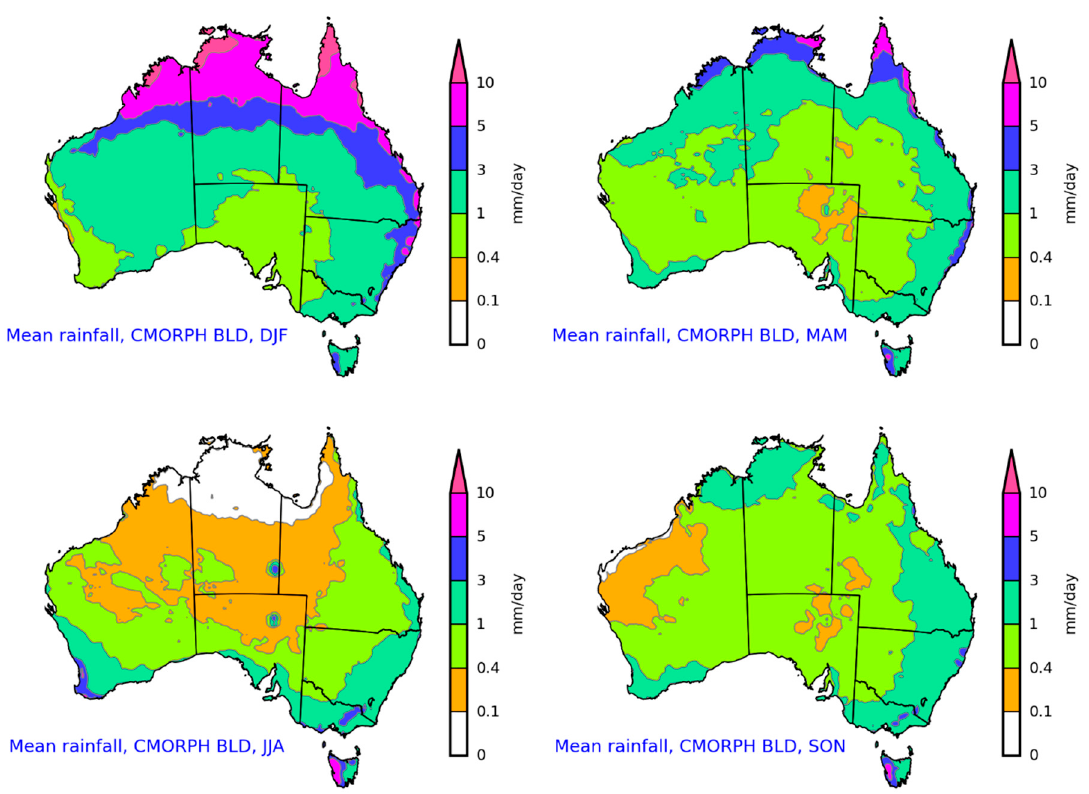
Figure 13. Mean CMORPH BLD rainfall by season from January 2001 to December 2018.